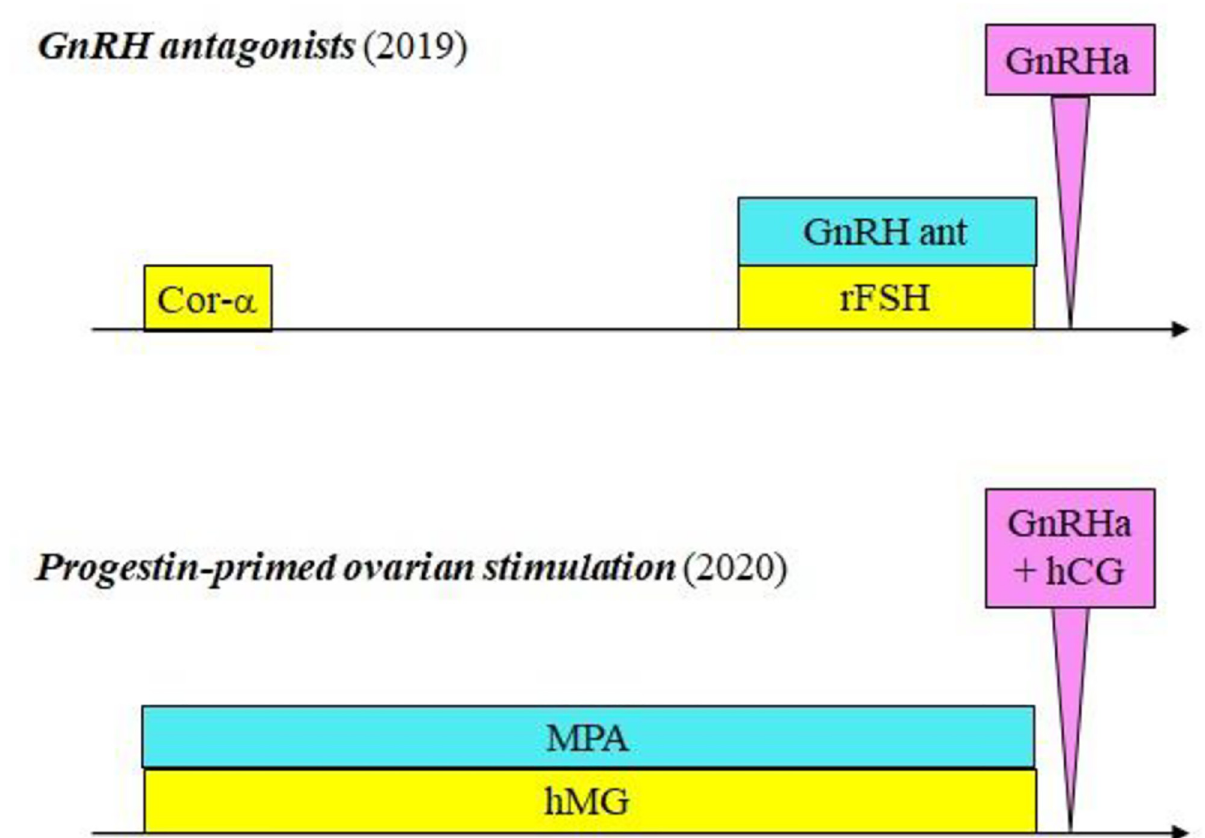
above 13–14 mm, they were prescribed also GnRH antagonist daily. The final maturation was obtained with GnRH agonist 0.2 mg. In the lower part of the figure , the regimen used in 2020 (progestin-primed ovarian stimulation). Women received both hMG and oral MPA daily. Final oocytes maturation was obtained with the concomitant administration of GnRH agonist 0.2 mg, plus hCG 1,000 IU. GnRH: Gonadotropin Releasing hormone. Cor- α